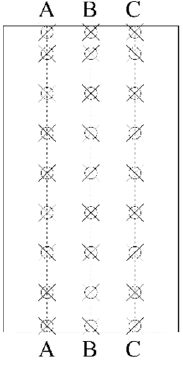
Figure 7. Measured lines at the cross-section (x = 10 m).